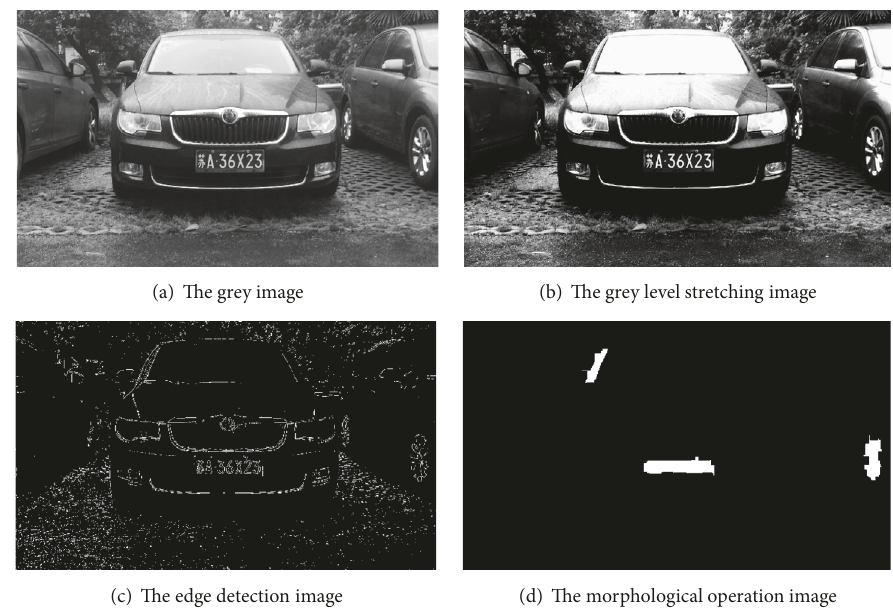
Figure 2: The result of each step in the original image